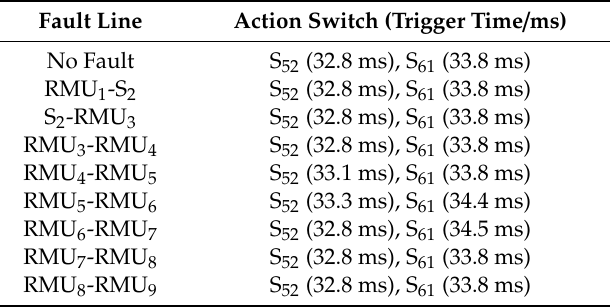
Table 6. Results of different communication line faults.